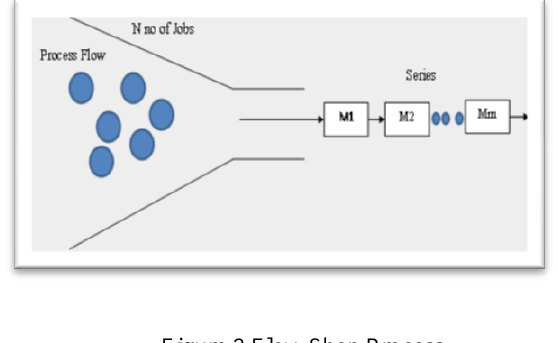
Figure 2.Flow Shop